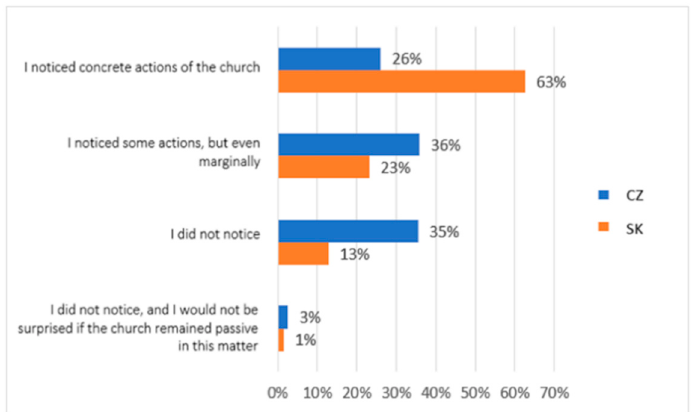
Figure 6. Descriptive statistics of the participants’ subjective perception of activities in social and pastoral service (comparison of the healthy population of eastern Slovakia and north-western Czech Republic). Legend: CZ—healthy population of north-western Czech Republic, SK—healthy popu- lation of eastern Slovakia. Source: own resource.